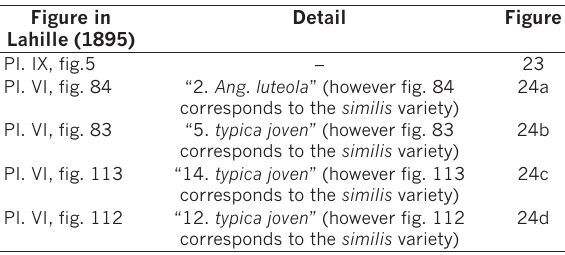
Table 8. Voluta angulata similis , specimens figured by Lahille (1895) with the detail of the inscriptions on their shells and fig - ures here.